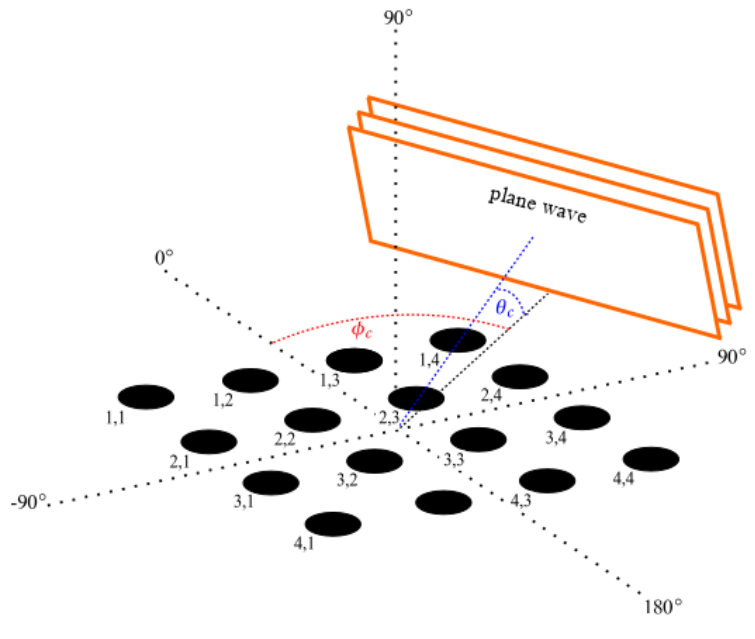
Figure 4. Plane wave approaching a LOFAR